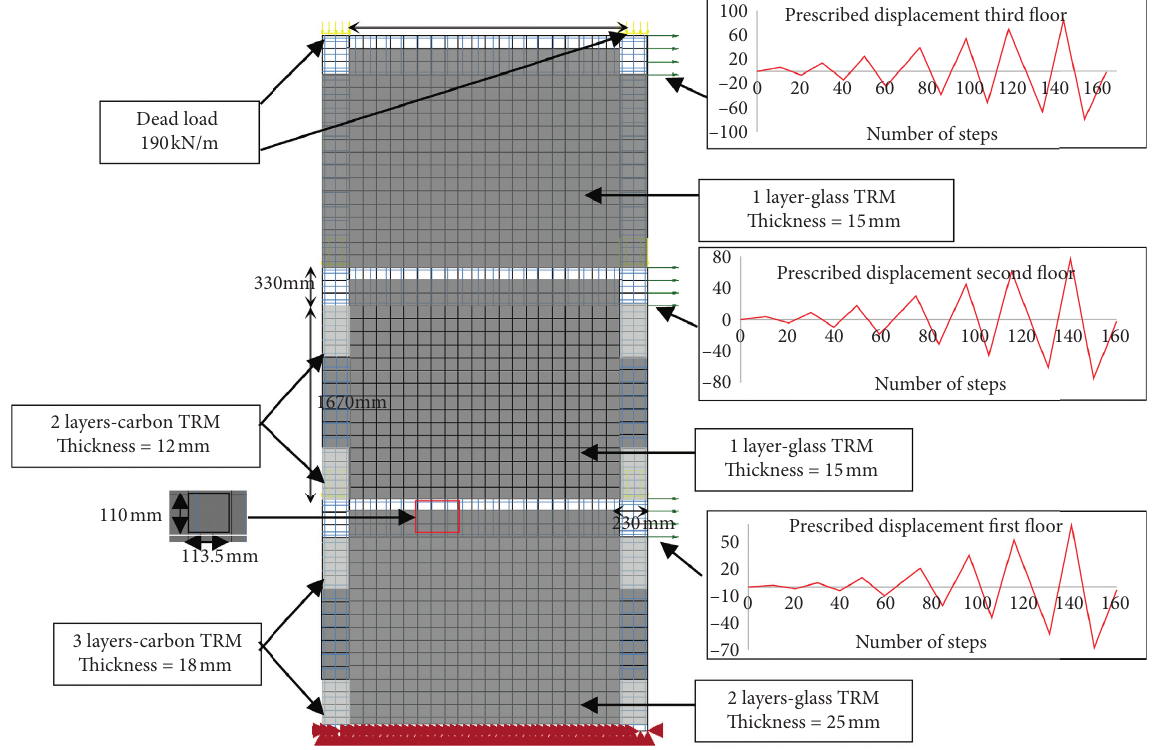
Figure 2: Geometry and mesh details of the FE